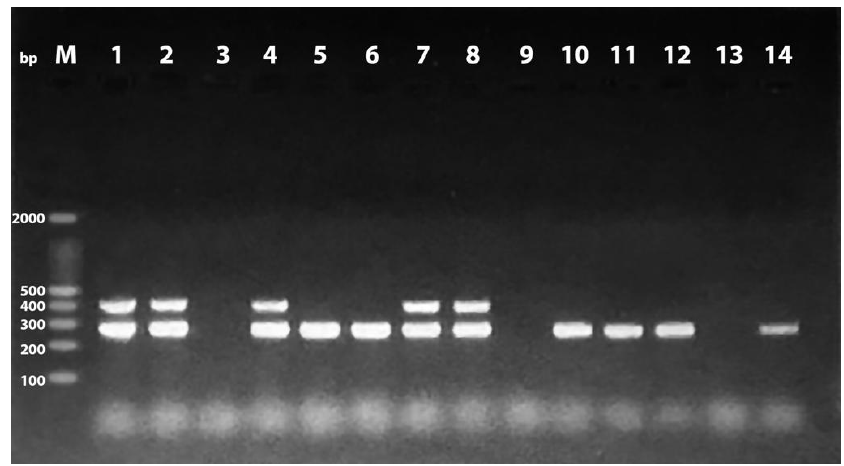
Figure 1. Multiplex PCR for identification of PAI IV 536 and PAI II CFT073 at 300 and 400 bp. Lane M: 100 bp DNA ladder; lanes 1, 2, 4, 7, and 8: positive for both PAI IV 536 and PAI II CFT073 ; lanes 5, 6, 10, 11, 12, and 14: positive for PAI II CFT073 ; lanes 3, 9, and 13: negative samples.